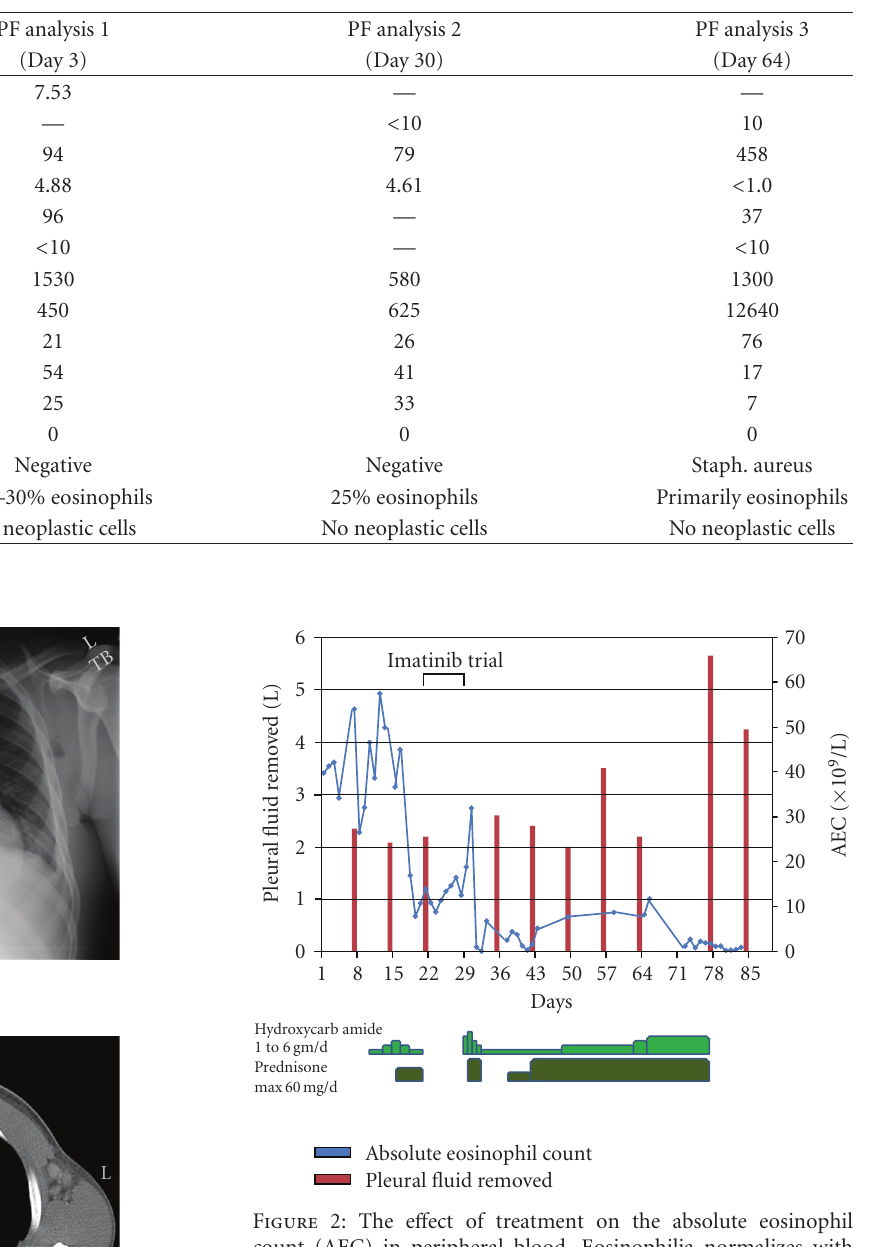
Table 1: Pleural fluid (PF) analysis at monthly intervals. This shows that the eosinophilia in pleural fluid persisted for months despite therapy.